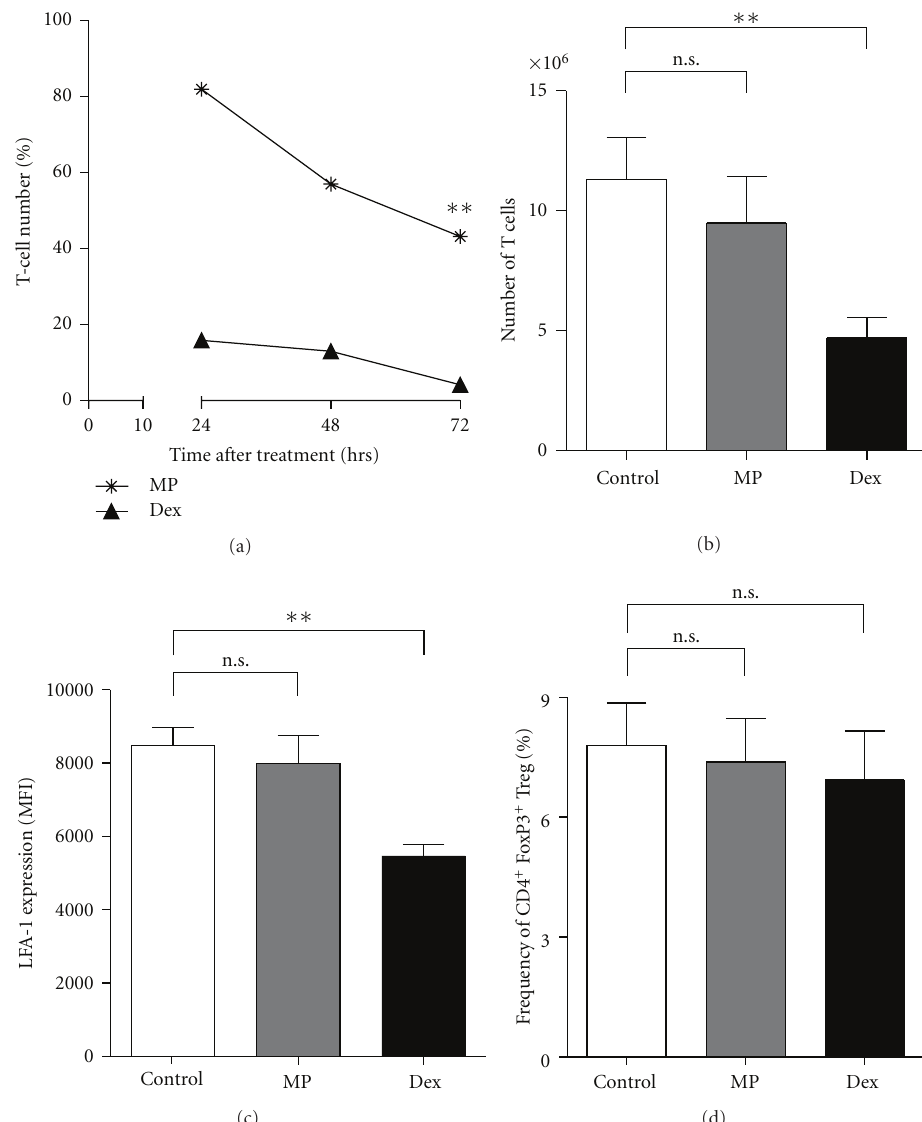
Figure 3: Flow cytometric analysis of peripheral T cells after preventive administration of GCs. (a) C57Bl/6 mice were treated three times with 100 mg/kg MP or Dex. Leukocytes were isolated from the spleens 24 hrs after the first, second, or third injection, stained for CD4 and CD3, and analyzed by flow cytometry. n = 2 (24hrs/48hrs), n = 5 (72hrs). Statistical analysis for day 3 was performed using the unpaired t -test ( ∗∗ P < 0 . 01). (b) C57Bl/6 mice were treated three times at days − 1, 0, and 1 with 100 mg/kg MP, 100 mg/kg Dex, or PBS as a control. At day 0, they were immunized with MOG 35-55 according to the standard protocol. 12 days after immunization, leukocytes were isolated from the spleens, and absolute T-cell numbers were calculated based on flow cytometric analysis after staining for CD4 and CD8. n = 6. Statistical analysis was performed using the unpaired t -test ( ∗∗ P < 0 . 01). (c) The relative expression level of LFA-1 was determined after three injections of MP or Dex in splenic T cells using the same mice as in (A). The mean fluorescence intensity (MFI) 24hrs after the last injection is depicted; n = 5 for each group. All values are depicted as mean ± SEM. Statistical analysis was performed using the unpaired t -test ( ∗∗ P < 0 . 01). (d) The percentage of FoxP3 + CD4 + CD25 + splenic T cells amongst all CD4 + T cells was determined 24 hrs after the last injection by flow cytometry; n = 5 for each group. All values are depicted as mean ± SEM. Statistical analysis was performed using the unpaired t